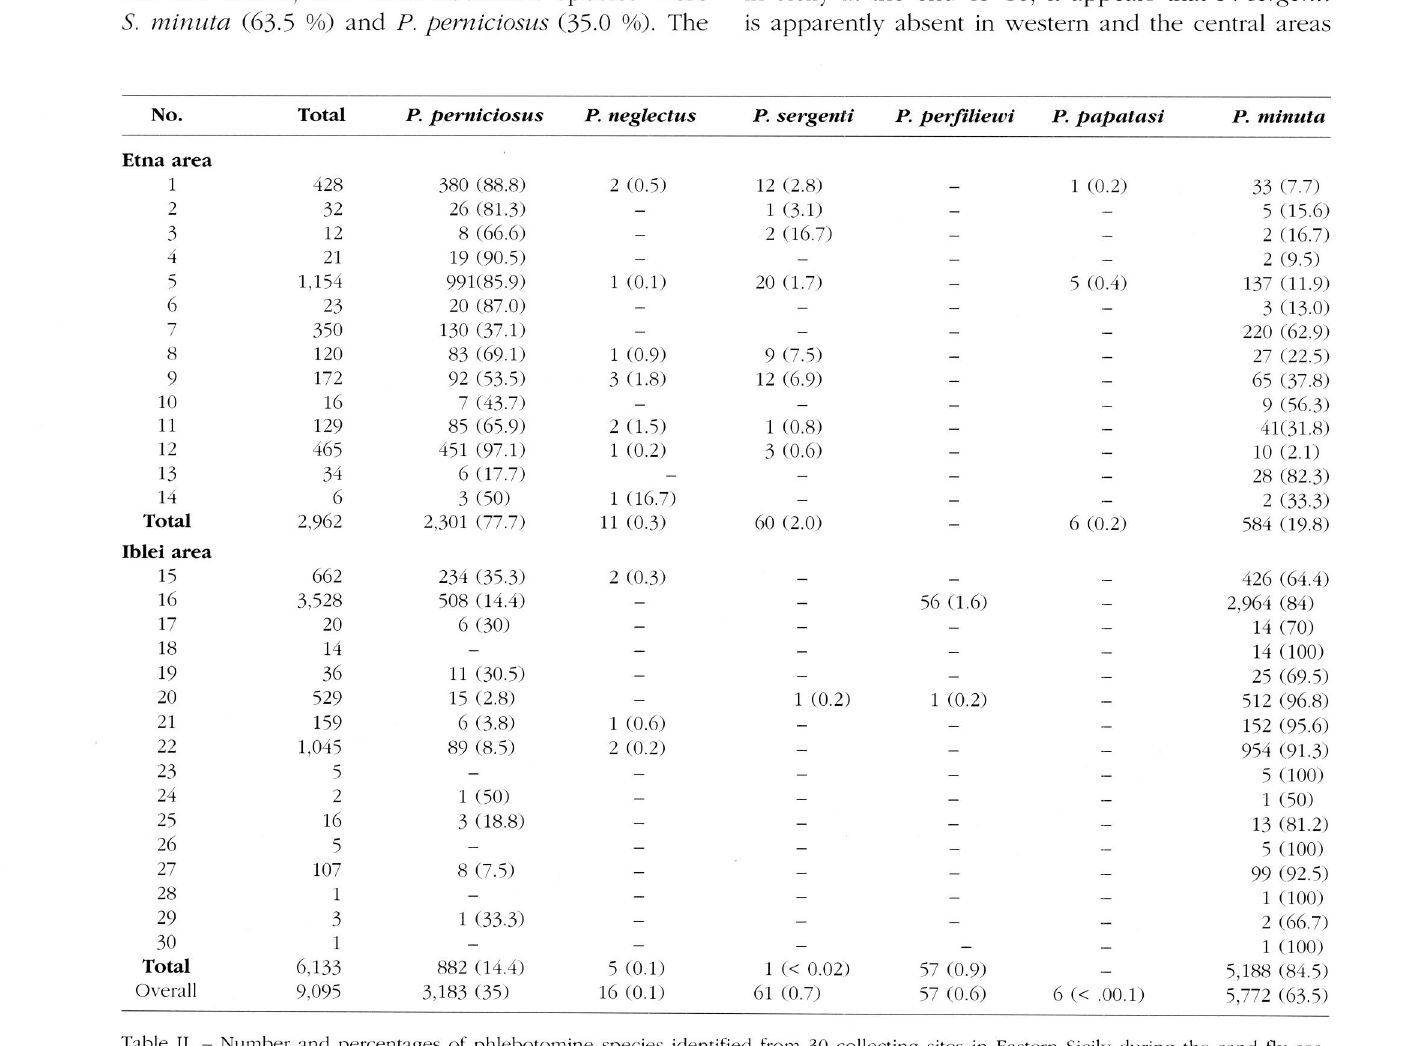
Table II. - Number and percentages of phlebotomine species identified from 30 collecting sites in Eastern Sicily during the sand fly sea­ sons 1997-1999.